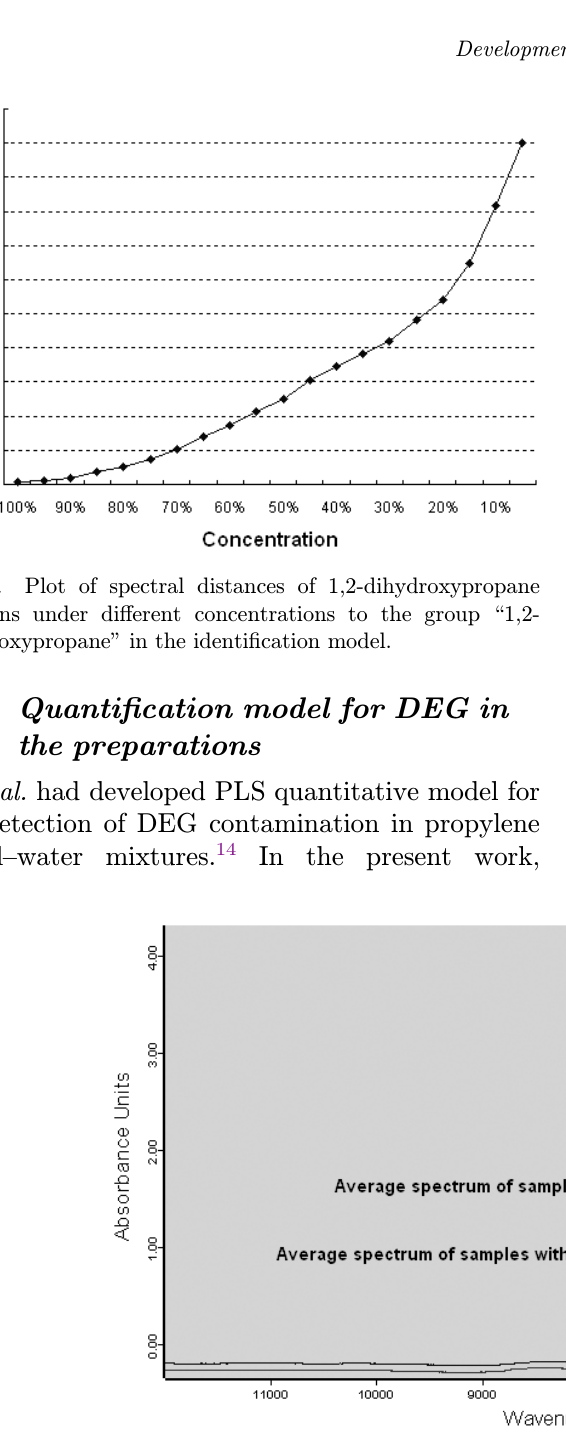
Fig. 4. Spectral ranges of the identi¯cation method for the preparations containing DEG (white